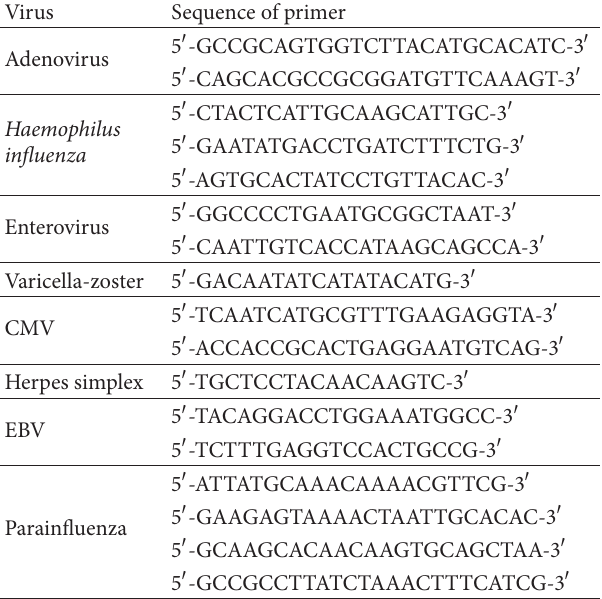
Figure 3: PCR results for adenovirus. Column M control. Columns 3 and 5 positive. Columns 1, 2, 6, and 9 negative. Columns 4 and 7 atypical.